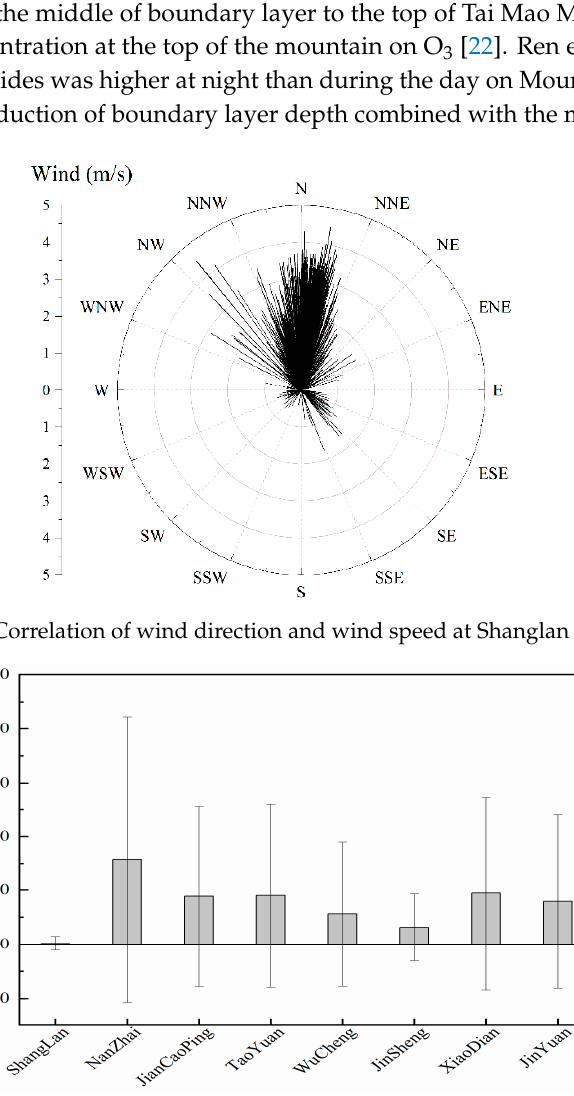
Figure 12. The average concentration of NO at eight sites between 23:00 and 6:00 when the O 3 concentration was high at Shanglan at night.